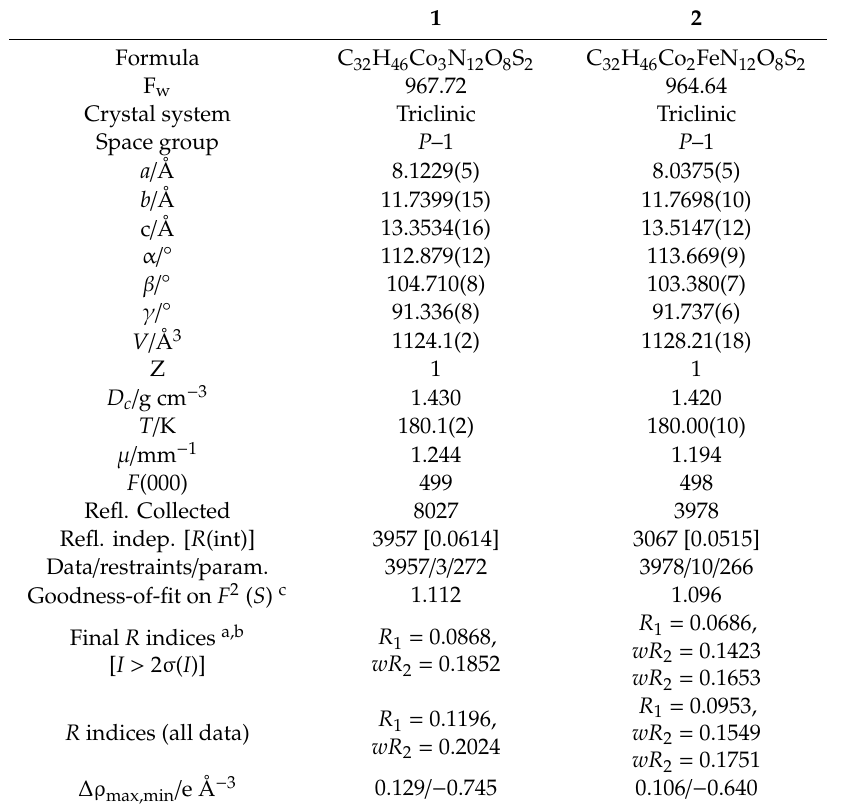
Table 3. Crystal data and structure refinement for 1 and